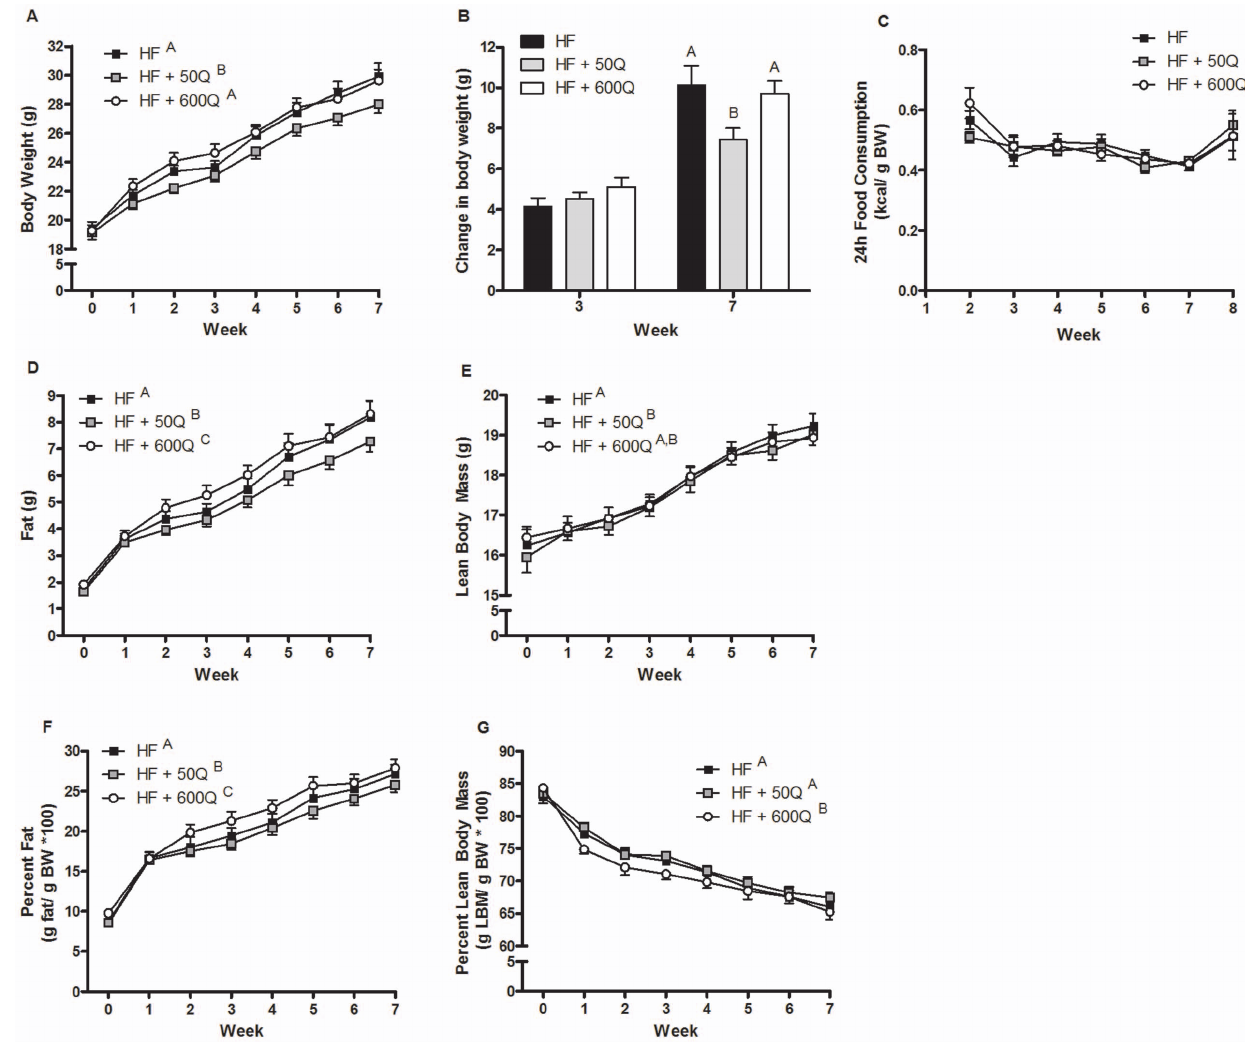
Figure 1. Body weight was measured weekly in mice fed a HFD (HF; black), HFD plus 50 ug/day quercetin (HF + 50Q; gray) or a HFD plus 600 ug/day of quercetin (HF + 600Q; white) and is presented as means ± SEMs (A) and as the change in body weight over the course of the study (B). ( C ) Weekly food intake was measured over a 48 h period and is shown as the average 24 h food consumption. Body composition was assessed by NMR weekly and is reported as fat mass ( D ), lean body mass ( E ), percent fat ( F ) and percent lean body mass ( G ). All values are reported as means 6 SEM. Significant differences between groups by a post hoc Tukey test is denoted by a difference in superscript.